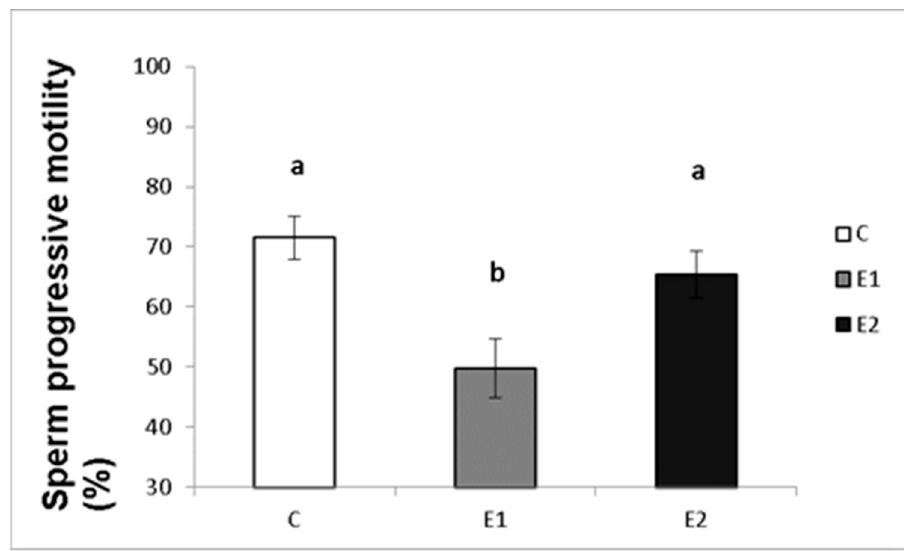
Figure 6. Sperm progressive motility in rabbits fed with green tea. C (without dietary green tea). E1–5 g green tea/100 kg normal food. E2–20 g green tea/100 kg normal food. Values and error bars express means ± SEM. a vs. b—difference is significant at p < 0.05.